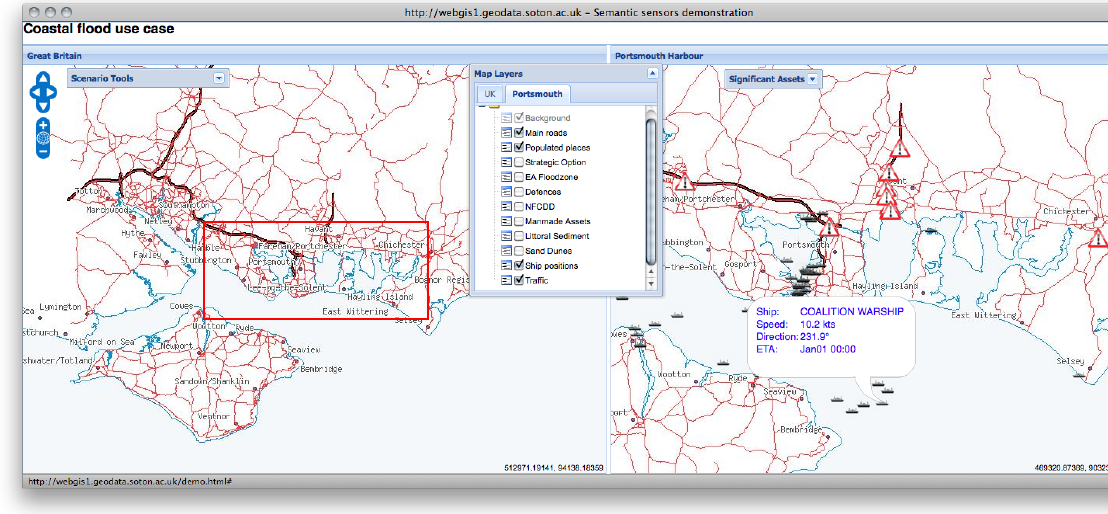
Figure 9. Screenshot of the initial layers displayed for the role Port Authority the region Portsmouth City/Gosport , and the task of Forecast ship safety